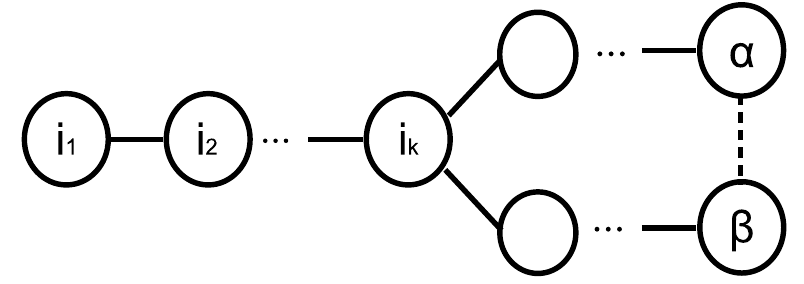
Figure 5. The case in which node α and node β have k common